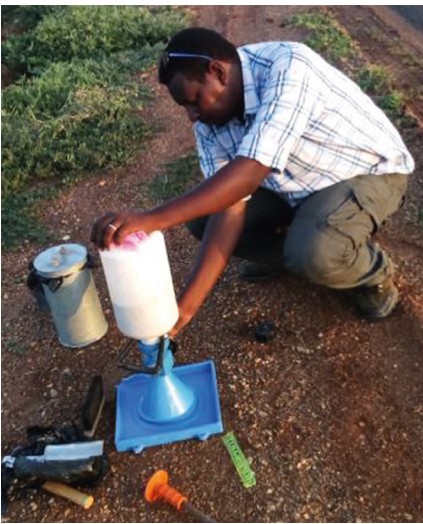
Figure 7: Field density test.